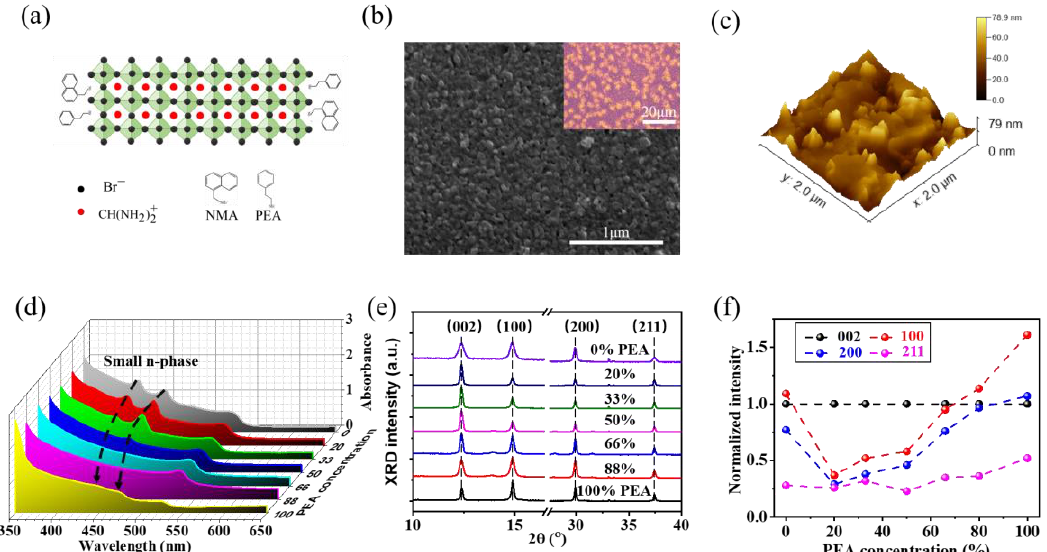
Figure 1. Phase distribution regulation of RPP (at the room temperature). ( a ) Schematic diagram of mixed A' cation RPP structure. ( b ) Optical and SEM images of RPP samples (66% PEA). ( c ) AFM image of RPP film (66% PEA), surface roughness ≈ 7.36 nm. ( d ) Absorbance spectra of mixed organic bulky spacer cations RPP films. ( e ) XRD patterns of mixed organic bulky spacer cations RPP films. The diffraction peaks at 14.8 ◦ (100) and 29.9 ◦ (200) are from large n-phase, and the diffraction peak at 12.4 ◦ (002) and 37.4 ◦ (211) is from small n-phase. ( f ) Normalized intensity of diffraction peaks as a function of PEA ratio.